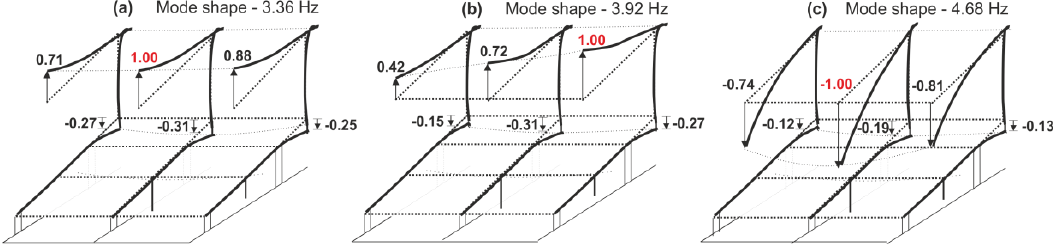
Figure 7. Identified mode shapes and natural vibrations: ( a ) 3.36 Hz, ( b ) 3.92 Hz, ( c ) 4.68 Hz .